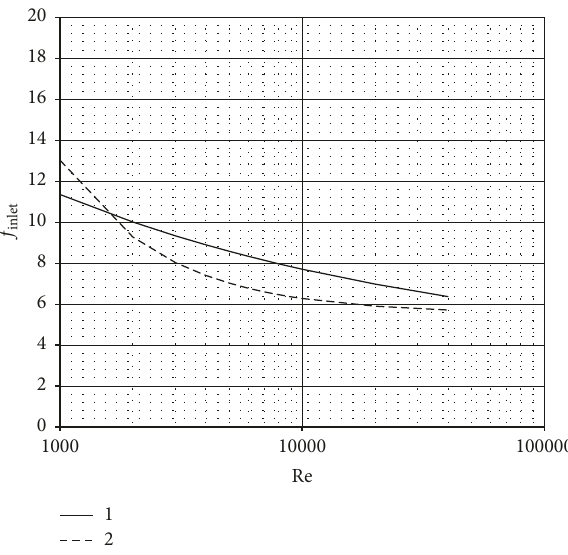
Figure 17: Pressure drop factor f equation (43) [23] and (ii) equation (16) the of three-component